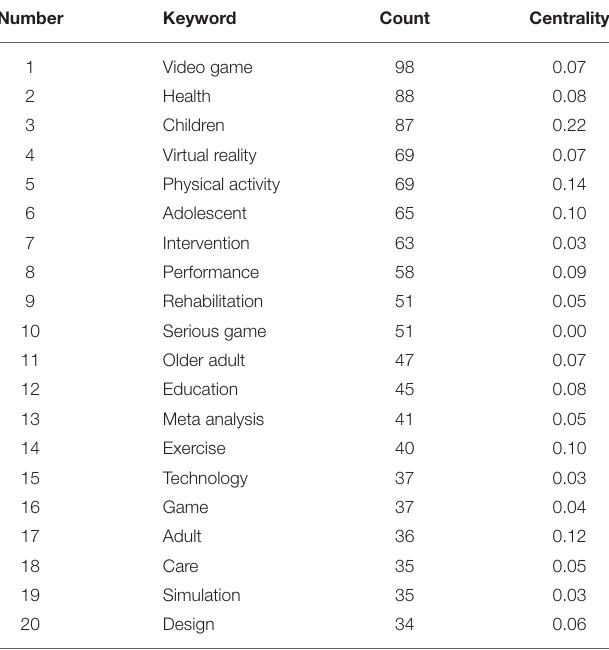
TABLE 5 | The top 20 keywords of the co-occurrence